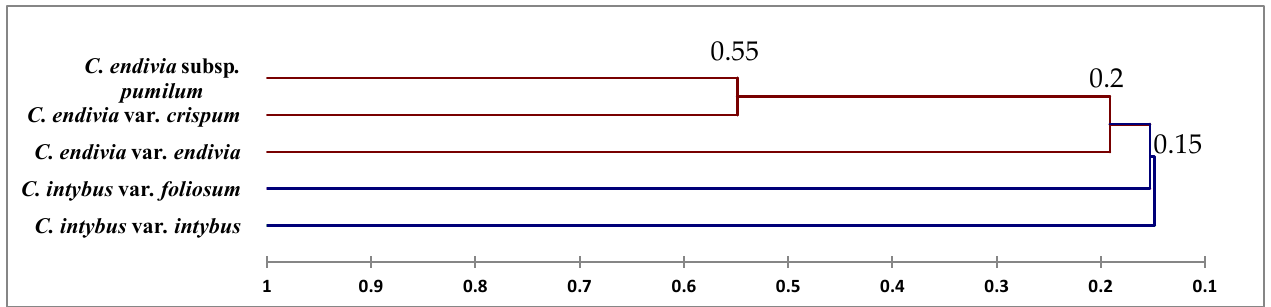
Figure 8. Dendrogram of the relationships between the five taxa of Cichorium based on 33 morpho- logical characters using UPGMA analysis.